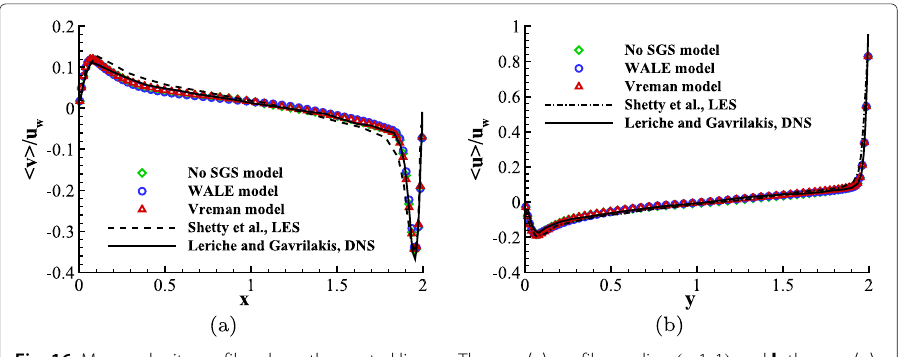
Fig. 16 Mean velocity profiles along the central lines. a The x − (cid:12) v (cid:13) profiles on line ( x ,1,1 ) and b the y − (cid:12) u (cid:13) profiles on line ( 1, y ,1